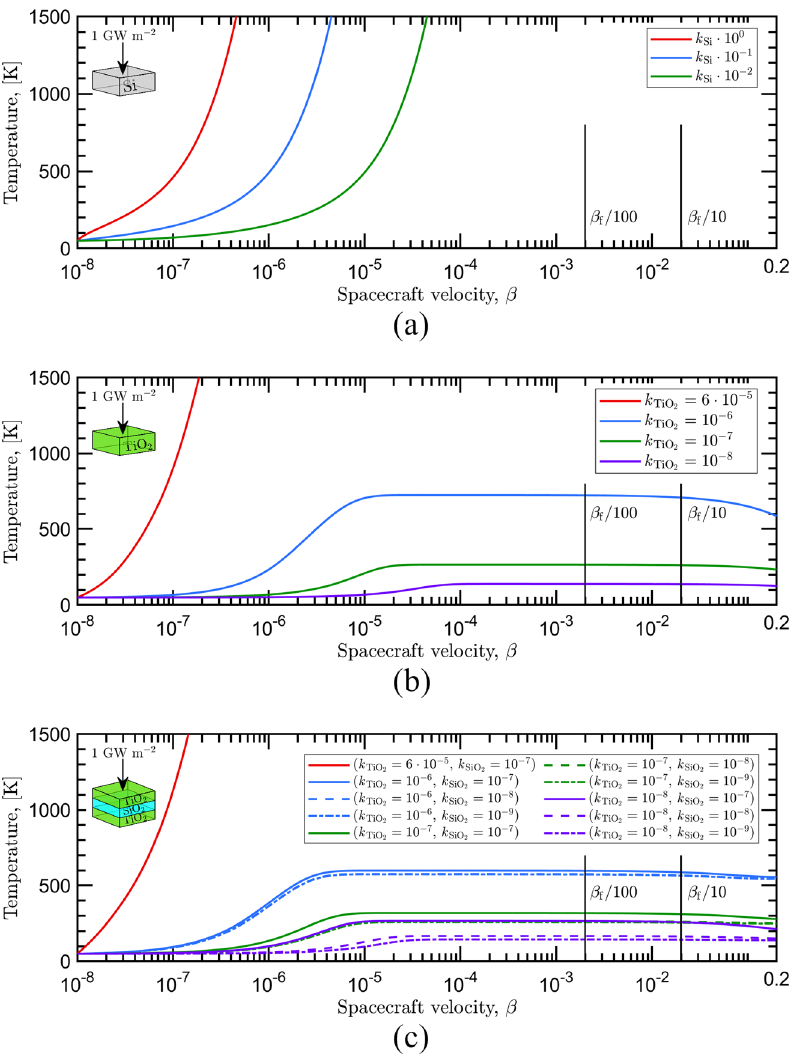
Fig. 5 Lightsail temperature evolution during the acceleration phase with a laser irradicance I 0 = 1 GW m − 2 . The acceleration phase of the Si single layer is shown in ( a ), of TiO 2 single layers in ( b ), and of TiO 2 /SiO 2 /TiO 2 tri-layer in ( c ). The temperature evolution is reported by considering different value combinations of the materials extinction coef fi cient. Here the starting temperature T 0 = 50 K and the laser irradiance is I 0 = 1 GW m − 2